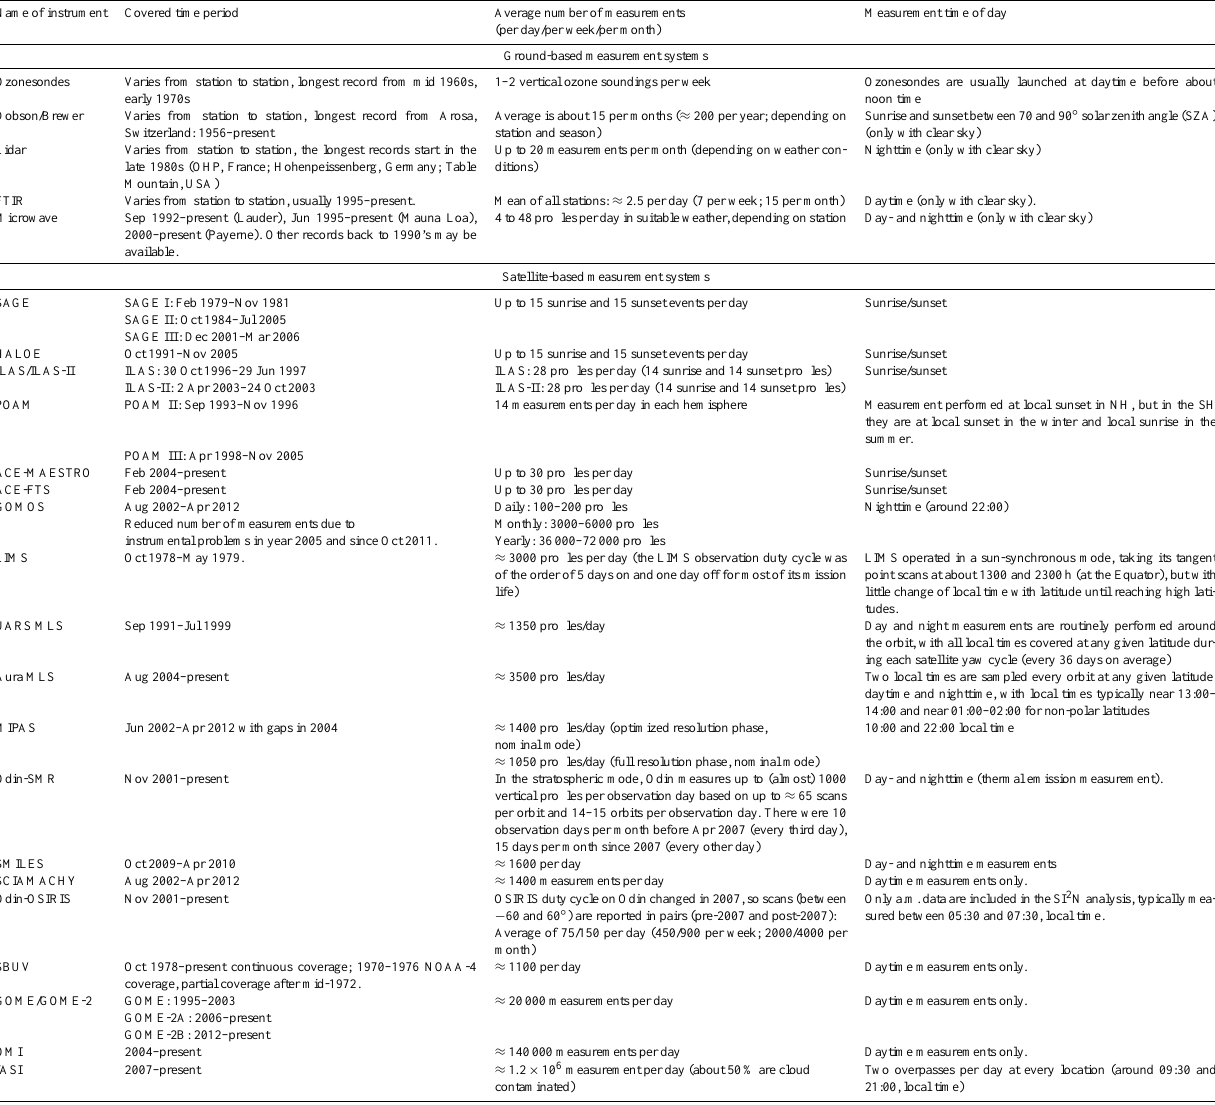
Table 1c. Summary of the covered time period, the number of measurements and the time for measurements for the five ground-based measurement systems and all described satellite measurement